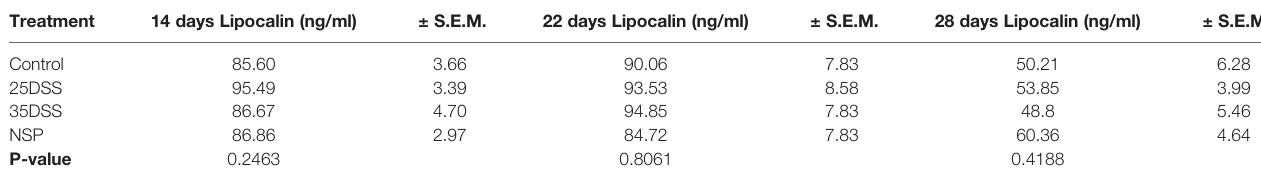
TABLE 7 | Lipocalin concentration in the serum of broilers submitted to different intestinal challenges at 14, 22 and 28 days of age. Treatment 14 days Lipocalin